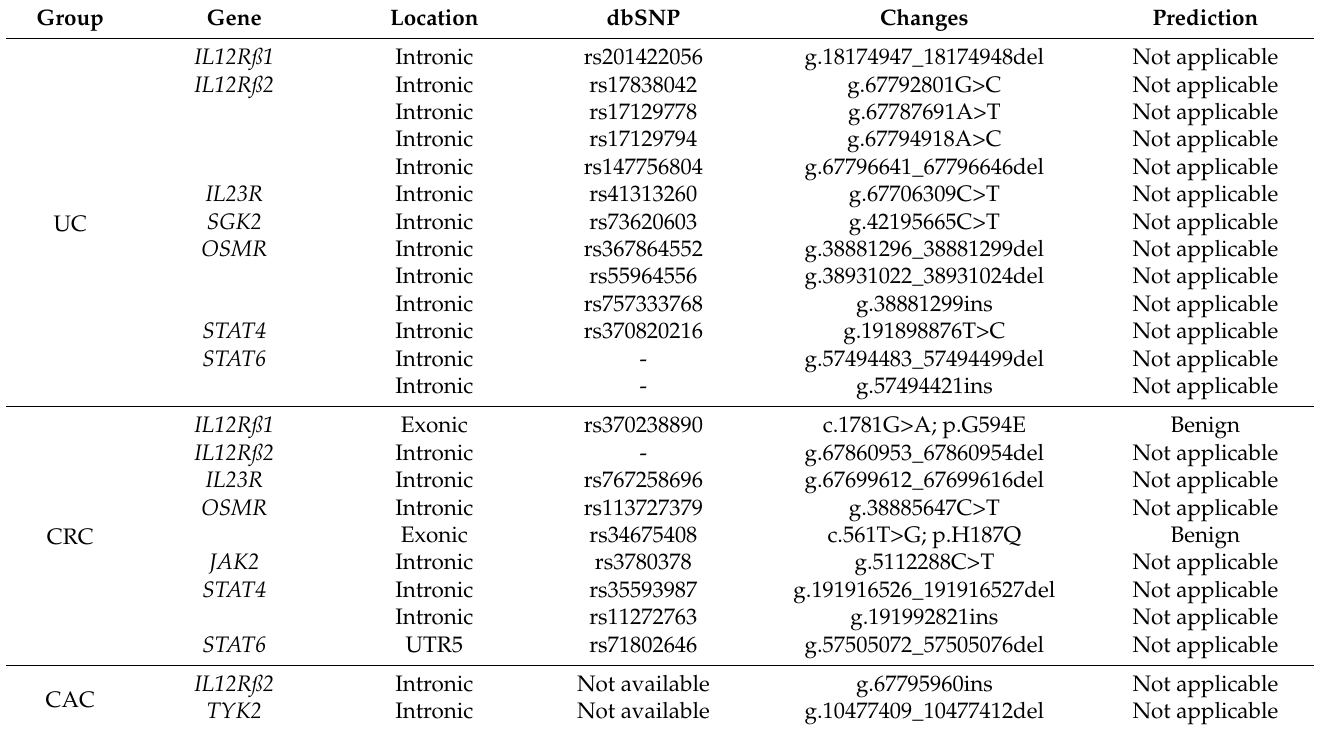
Table 2. List of recurrence somatic variants in two samples or more in each UC, CRC and CAC group. UC, ulcerative colitis; CRC, colorectal cancer; CAC, colitis-associated cancer.